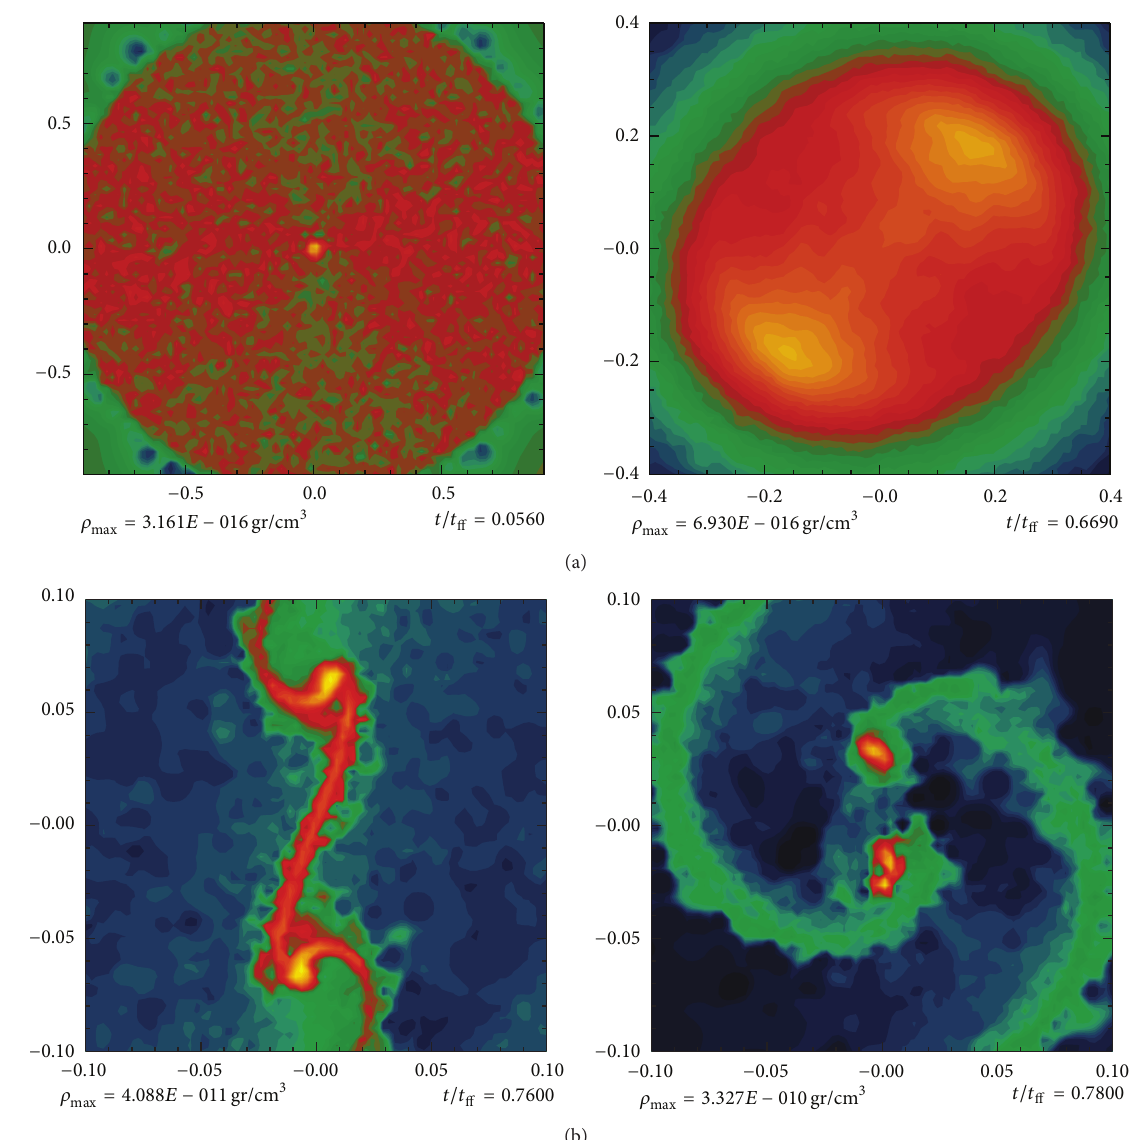
Figure 10: Iso-density plots for a thin slice of matter parallel to 𝑥𝑦 plane for the collapse of the rotating core.